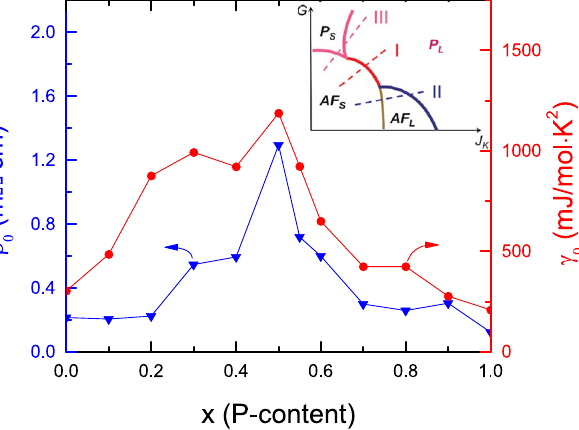
Figure 5. The evolution of residual resistivity ρ and right axis, respectively. Inset presents the global phase diagram for heavy fermion systems 36 . Here we actually used the resistivity and Sommerfeld coefficient values at T = 0.5 and 0.45 K as ρ